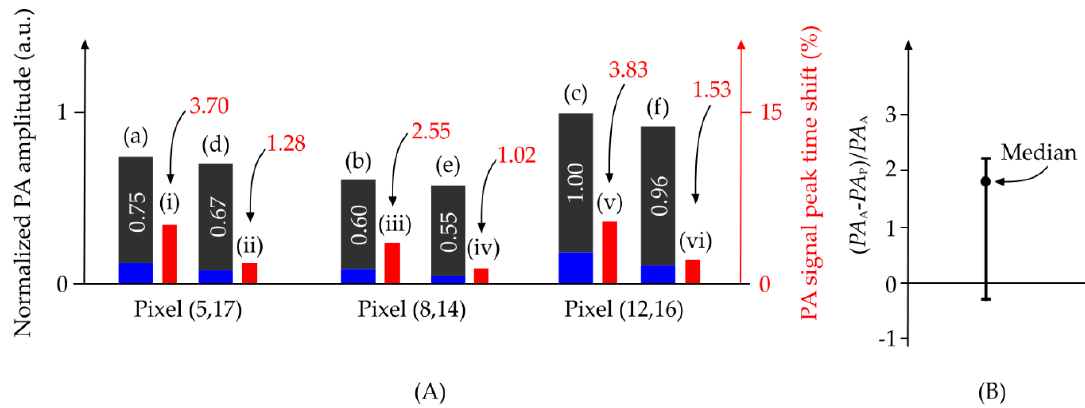
Figure 3. Performance comparison between averaging and the proposed denoising method on three photoacoustic (PA) signals. ( A ) (a–c) Denoised PA signals using averaging 150 signals for three-pixel locations, (d–f) denoised PA signals using the proposed method for the same pixels when 15 acquisition epochs were used, (i, iii, v) PA signal peak time-shift when averaging, and (ii, iv, vi) PA signal peak time-shift when the proposed algorithm was used. ( B ) Percentage of difference between the PA amplitude obtained from averaging (PA A ) and PA amplitude obtained from the proposed algorithm (PA P ) divided by the PA amplitude obtained from averaging, for all pixels in the image. The dark grey and blue color bars in A indicate the peak amplitude of the PA signal and noise at the pixel location respectively. The red color bars represent the PA peak time-shift percentage.